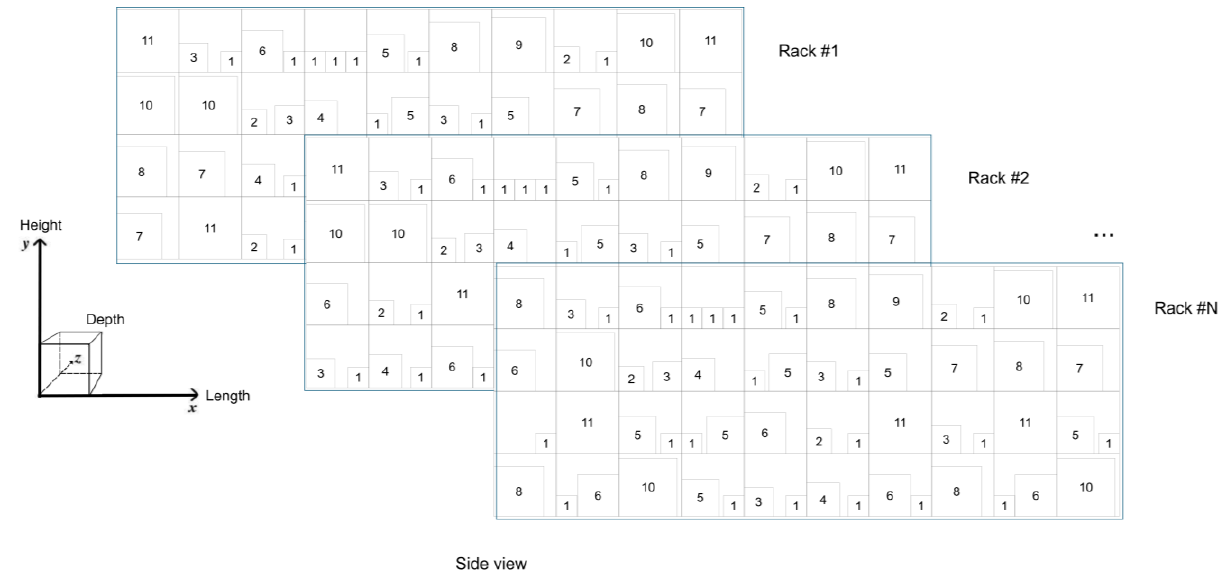
Figure 5. The side view of Type C racks.